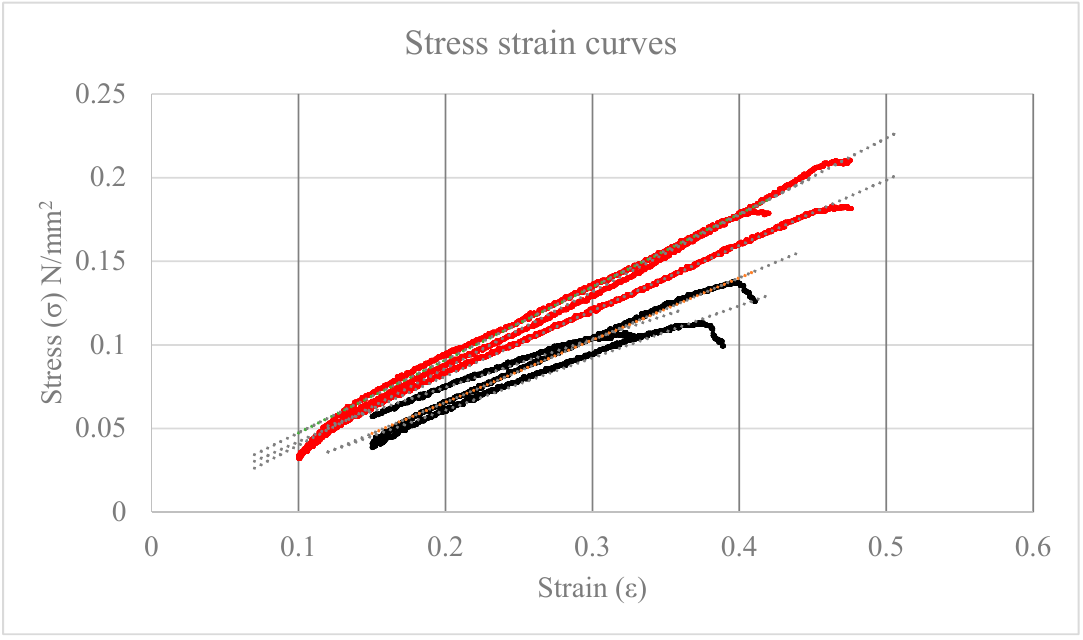
Figure 1. Relevant stress-strain curves: ALG controls (Y = 0.32X – 0.0045, r 2 = 0.989 n = 3) in RED; alginate/nanocrystalline cellulose (ALG/CNC, 5% and 3% w/v ) + silver nanoparticles (AgNP, Y = 0.43X – 0.0041, r 2 = 0.998 n = 3) in black.